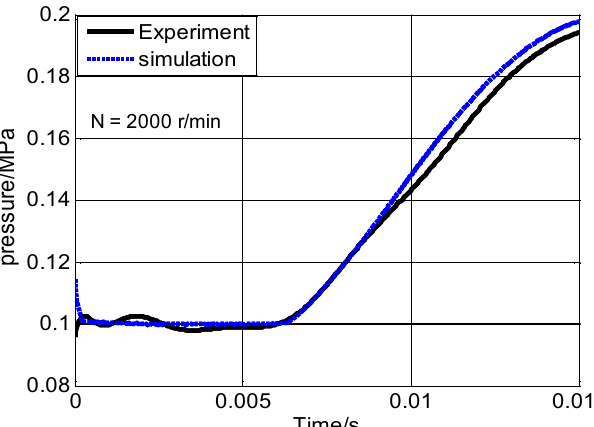
Figure 4. Comparison of experimental and simulation pressure.